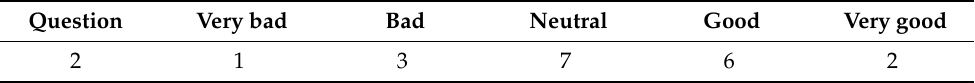
Table 7. Student questionnaire responses related to the previous perception of mathematics.